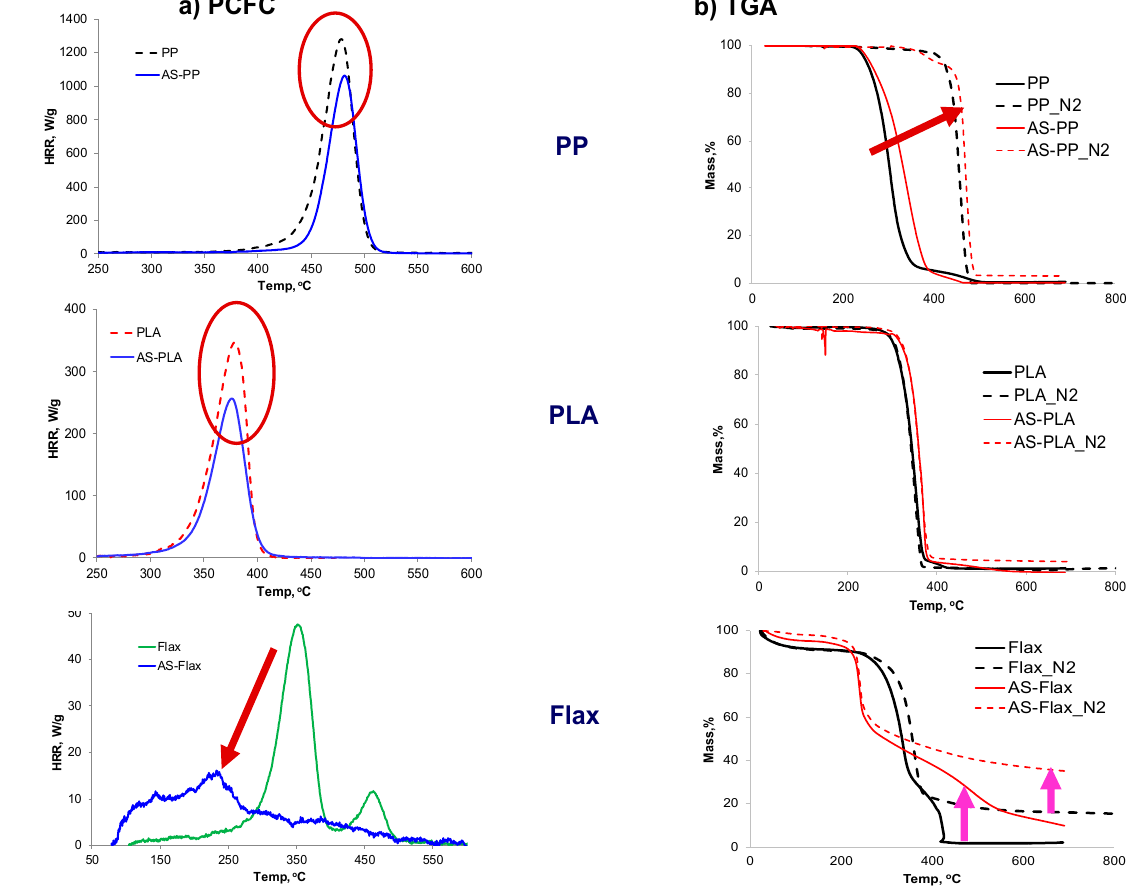
Figure 5. ( a ) PCFC and ( b ) TGA curves (in air and nitrogen) of ammonium sulfamate (AS) treated PP, PLA, flax, flax/PP, and flax/PLA.